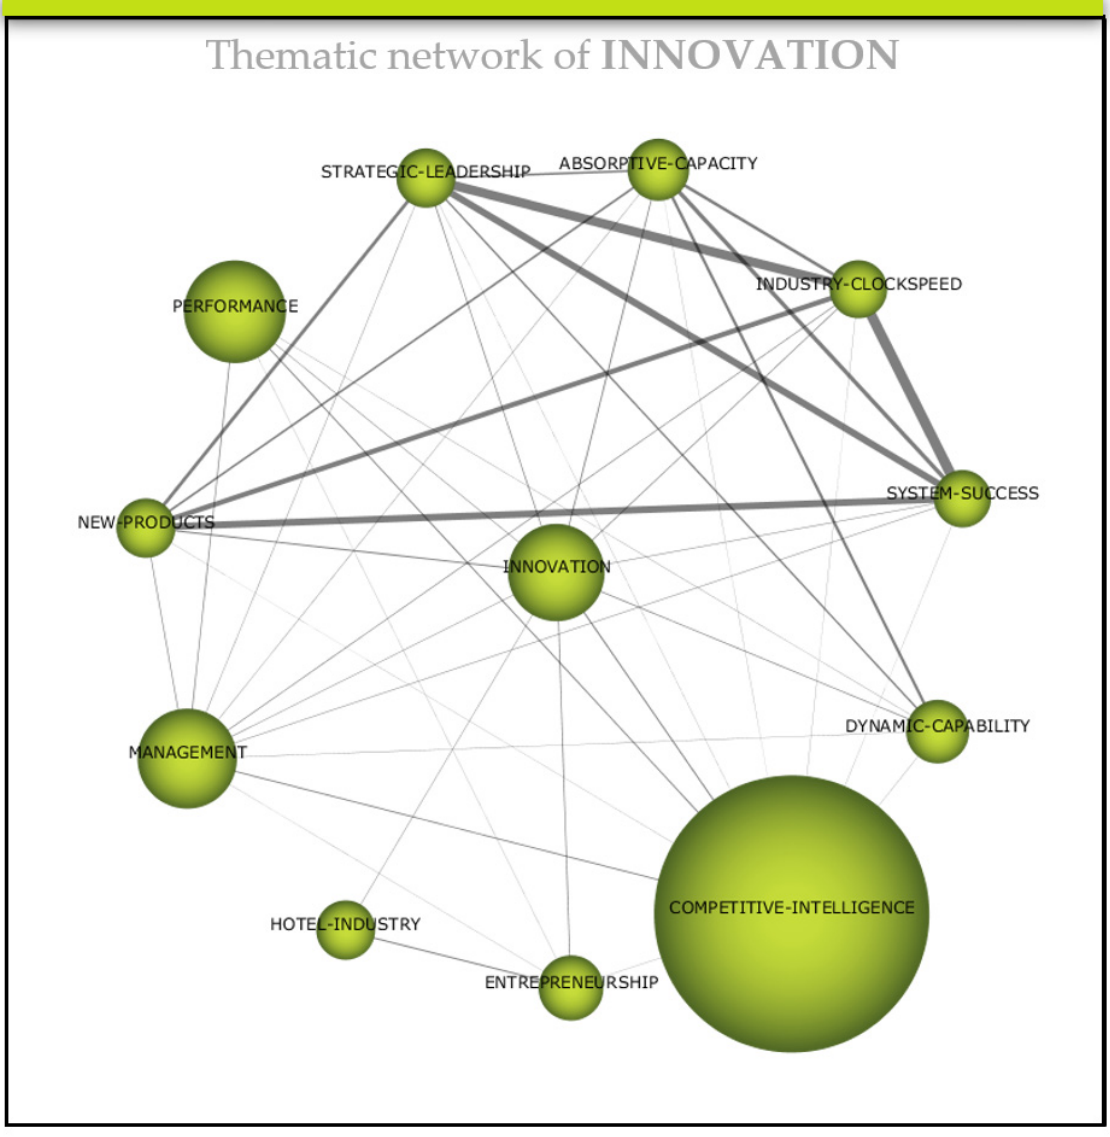
Figure 3. Thematic network of INNOVATION. Primary Documents period 1985–2021. Source: Prepared by the authors on the basis of SciMAT data.